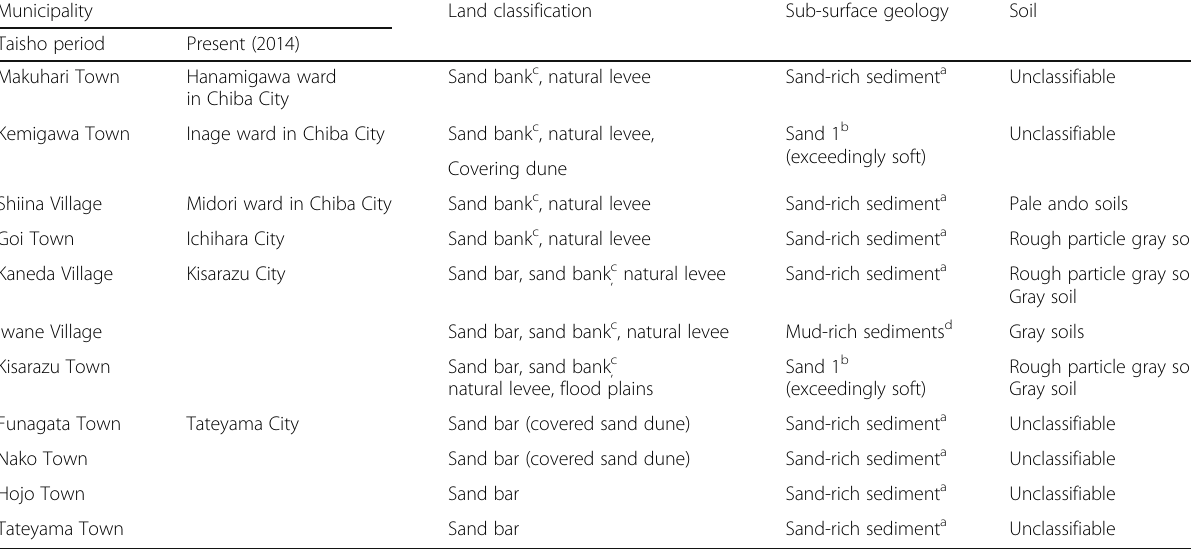
Table 1 Land classification, sub-surface geology, and soil type in study area